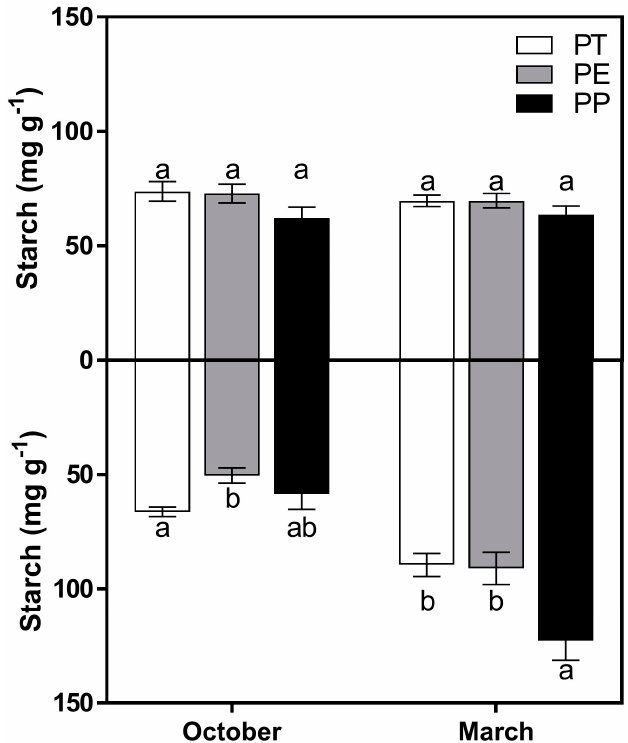
Figure 3. Mean ( ± SE) starch concentrations (mg g − 1 ) for species (PT = Pinus tadea , PE = Pinus elliottii , and PP = Pinus palustris ) by month (October and March) by organ (stem and root). Bars with different letters within an organ indicate significant difference ( α = 0.05).